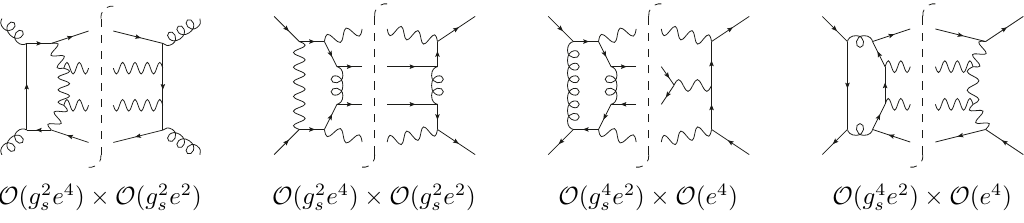
Figure 2 . Representative virtual corrections at